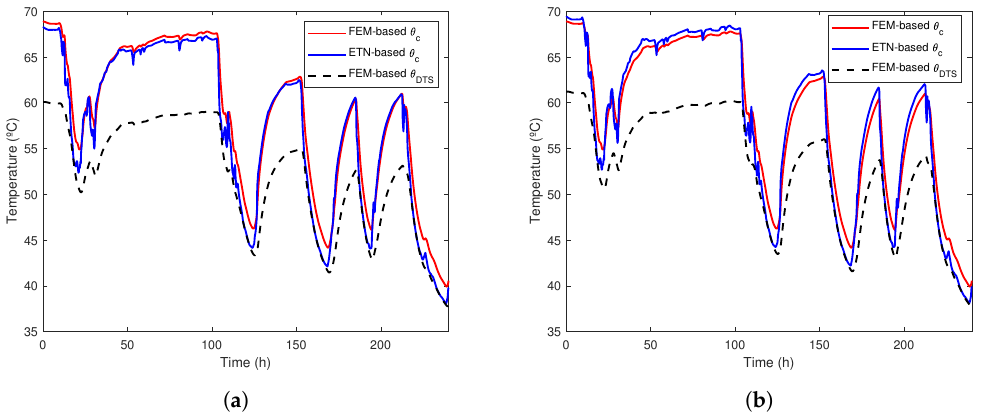
Figure 25. Estimation results with deviations in the sensor position: ( a ) + 5%; ( b ) − 5%.